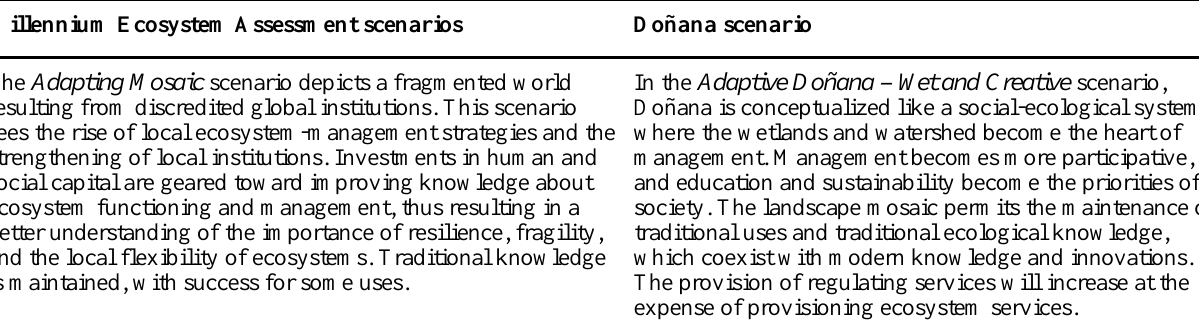
Table 4 . Descriptions of Millennium Ecosystem Assessment's Adapting Mosaic scenario (Cork et al. 2005) and the Adaptive Doñana – Wet and Creative